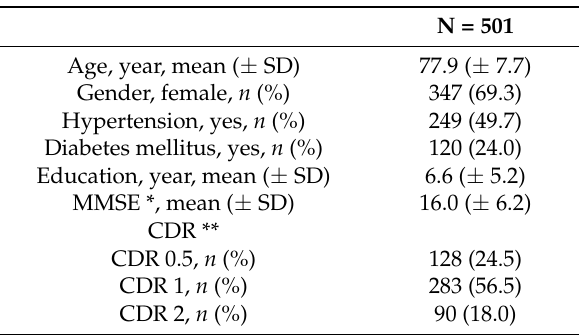
Table 1. Demographic characteristics of Alzheimer’s disease participants.